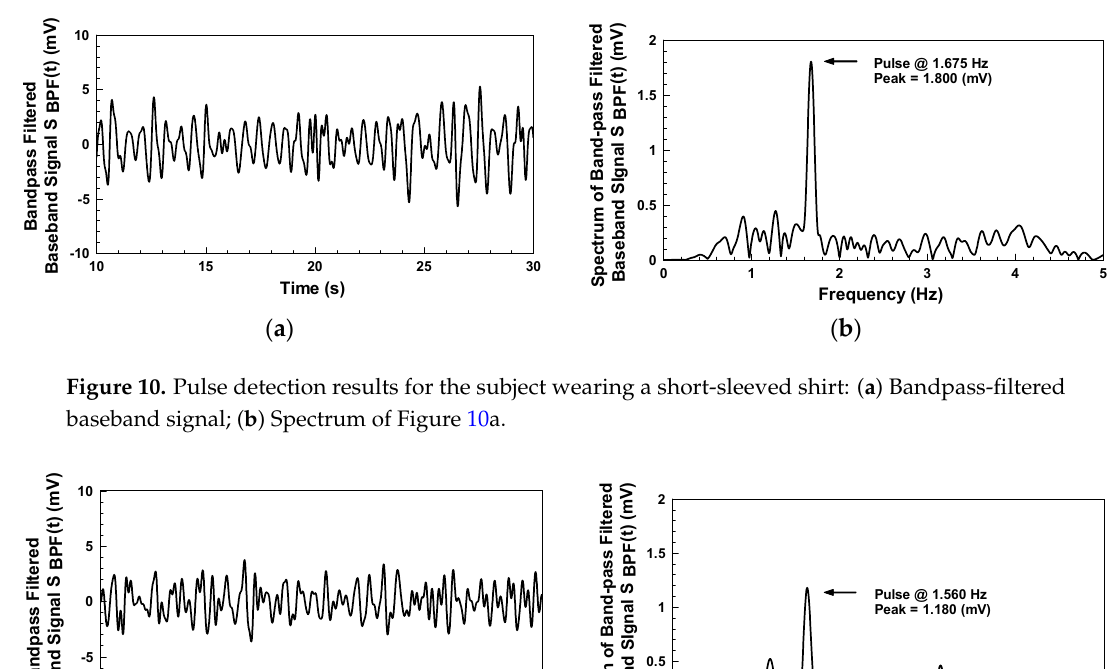
( b ) Figure 9. Photograph of the wrist pulse rate monitor. ( a ) Active antenna wristband; ( b ) Frequency discriminator. Table 2. List of components used in the wrist-worn pulse rate monitor. Component Model Number Operating Frequency Specifications Active antenna SILO